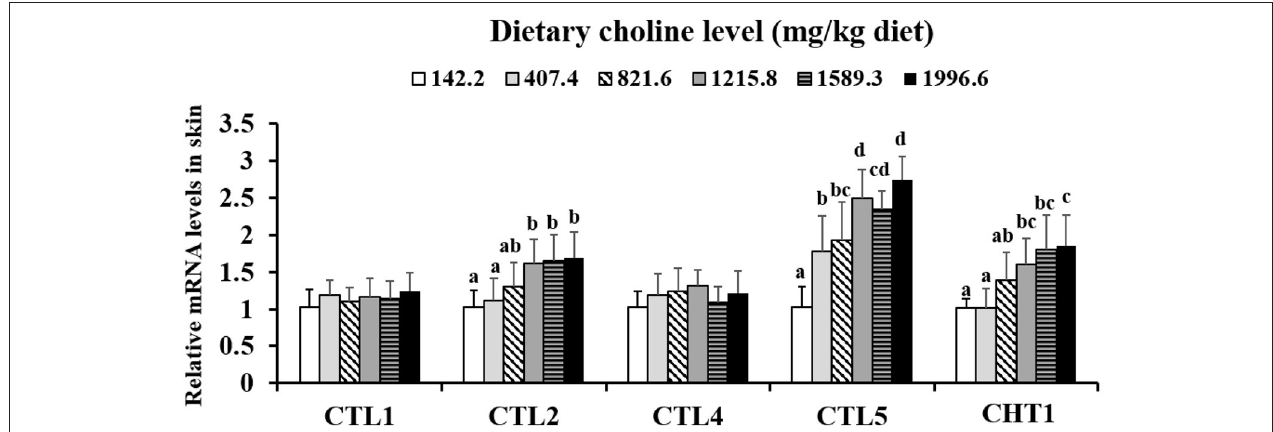
FIGURE 1 | Effects of dietary choline on choline transporter gene level in the skin of juvenile grass carp ( Ctenopharyngodon idella ) after infection with A . hydrophila . Data represent means of six fish in each group, error bars indicate S.D. Values having different letters are significantly different ( P < 0.05).